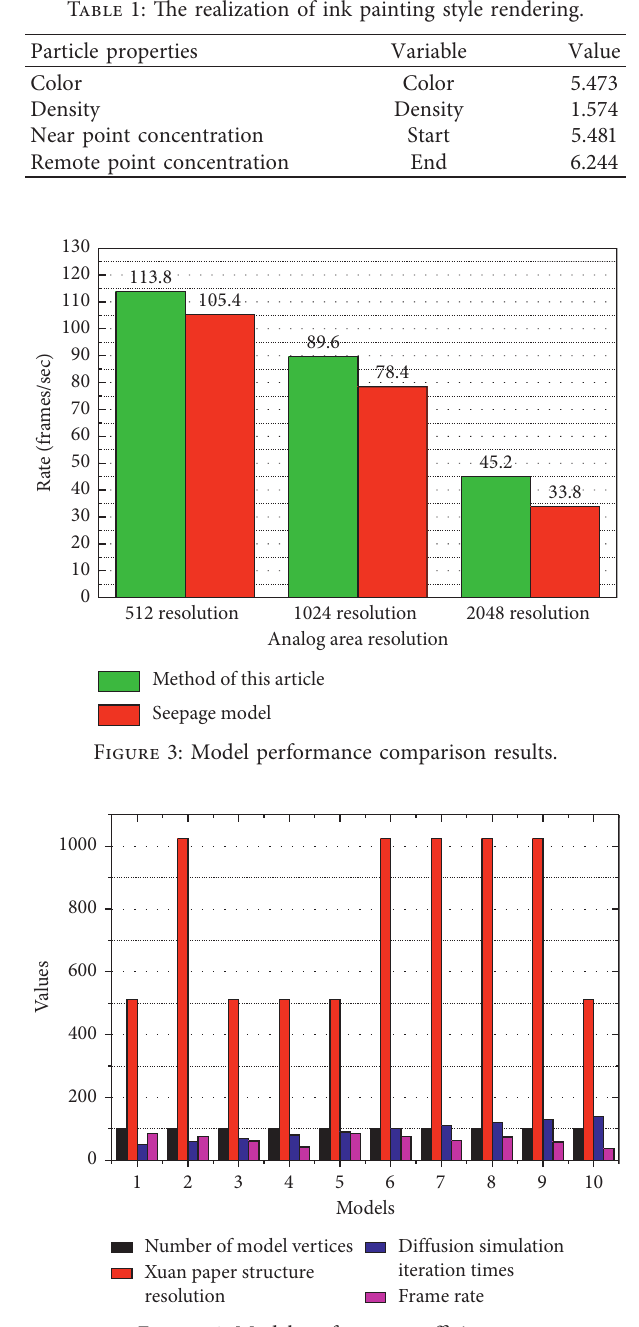
Figure 4: Model performance